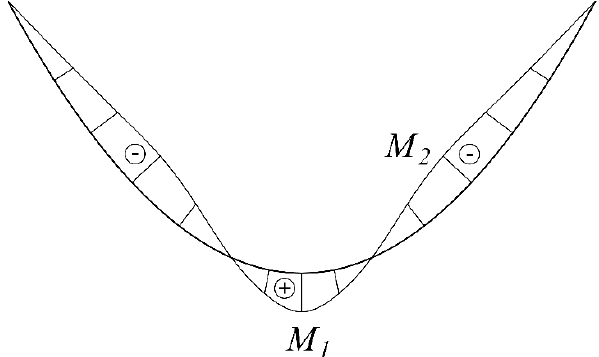
Figure 3. Schematic diagram of bending moment distribution.